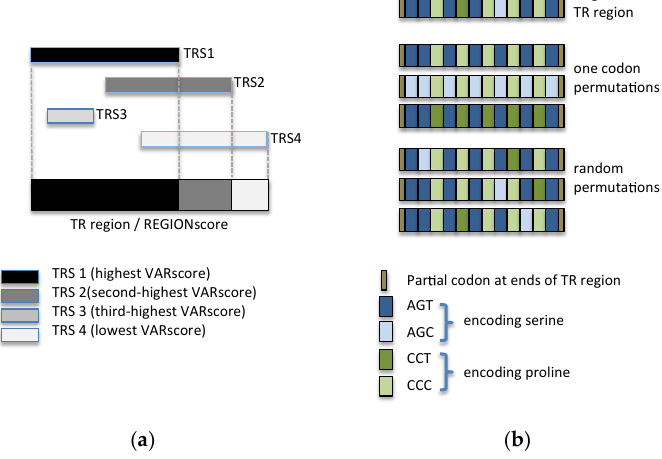
Figure 1. TRANALYZER processing of TR sequences ( a ) Determination of REGIONscores. REGIONscores are calculated by adding, to the VARscore of TR stretches (TRS) with higher VARscores, fractions of VARscores of lower-scoring stretches. The fraction of the score of the lower-scoring stretch added corresponds to the fraction of non-overlap with the higher scoring stretch. If an entire lower-scoring stretch is in a region covered by a higher-scoring stretch (such as TRS3), its VARscore is not considered; ( b ) Search for the maximum REGIONscore of a TR region encoding a series of serine/proline repeats by permutating it, without altering the amino acid sequence, by using either only one type of codon for each amino acid or by randomly shuffling codons.